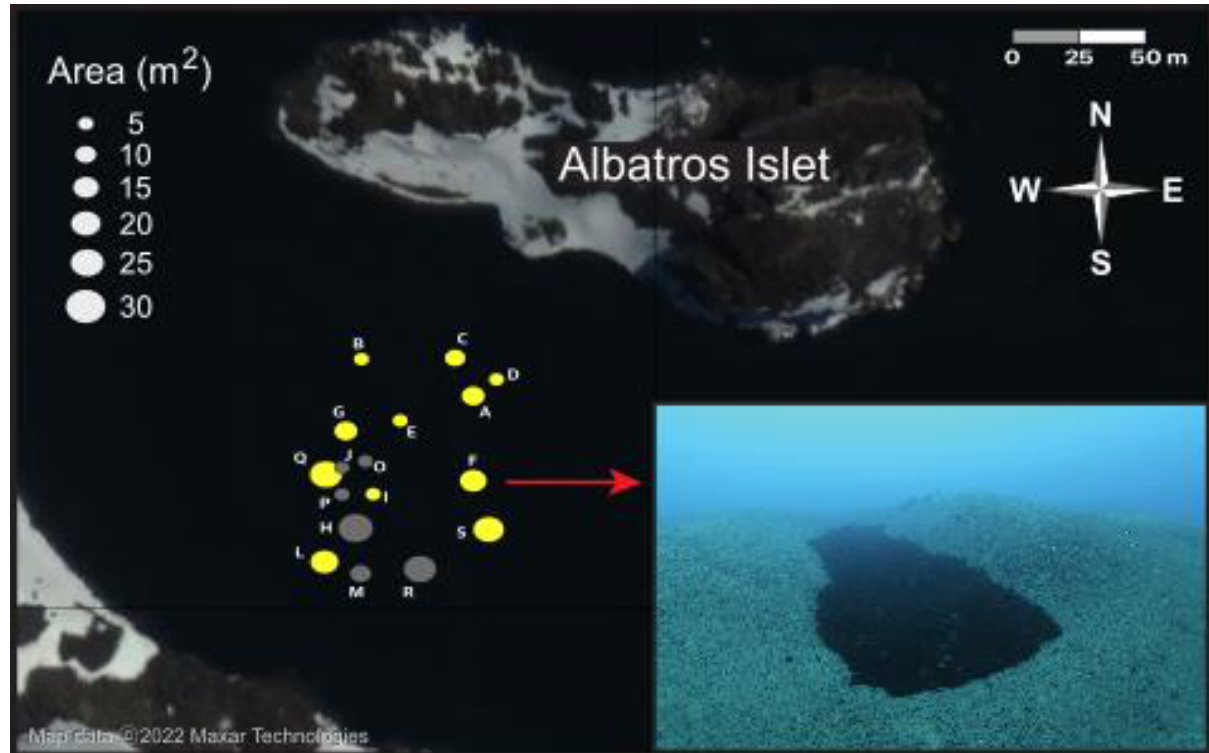
Figure 2. Distribution and size of the 17 ice pits documented in 2018. Algal biomass and composition were sampled with quadrats in eleven ice pits (yellow shapes). Ice pits were distinguished from the surrounding soft sediment seabed by distinct algal deposits within depressions (inset photo).